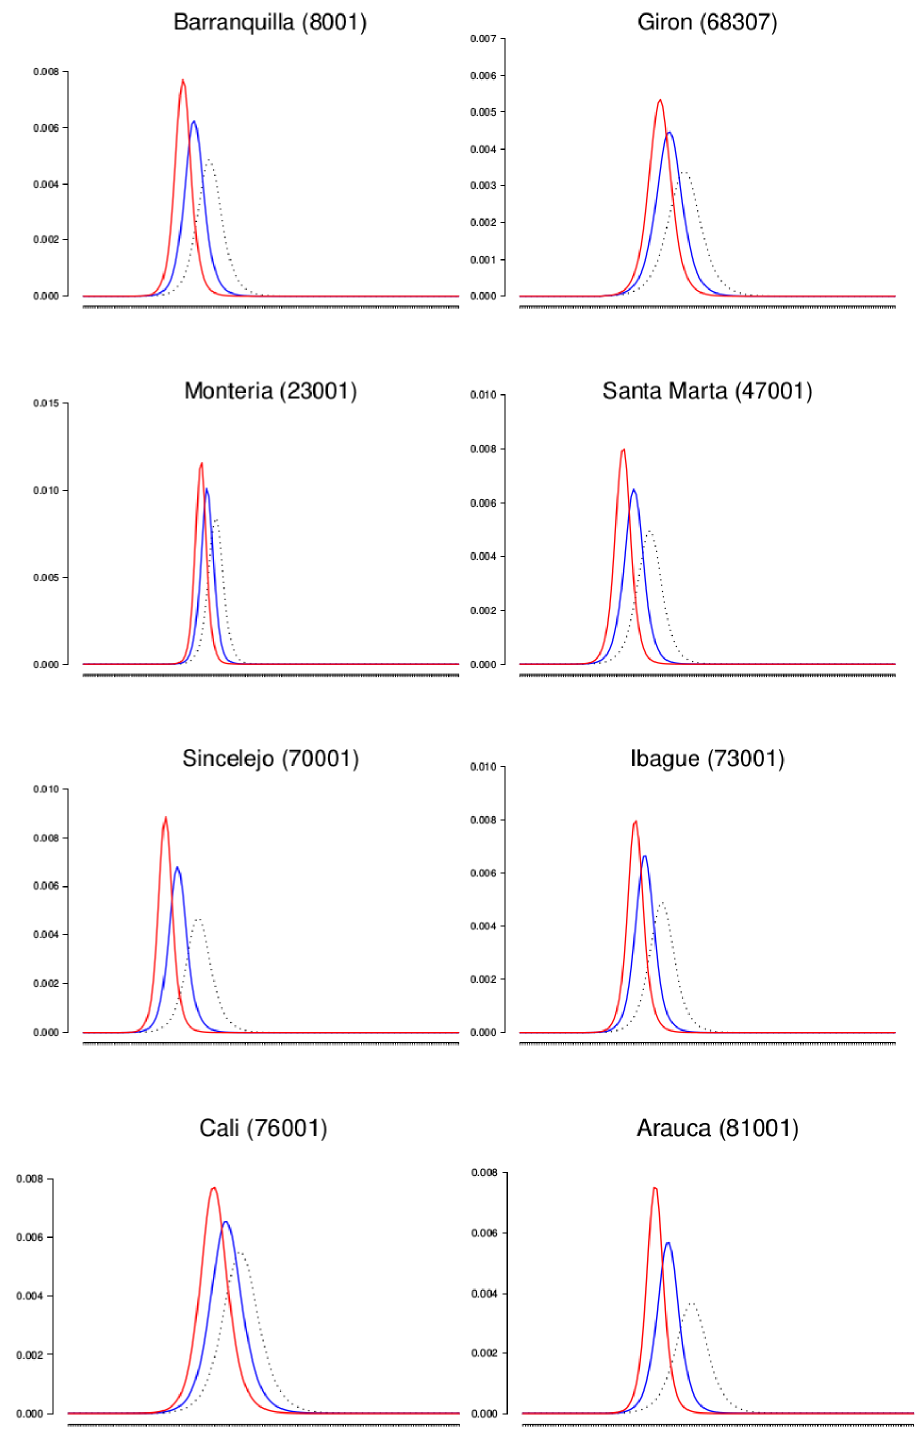
Fig 6. Comparison of the proportion of symptomatic infections of the best fit and the behavior of the epidemics when the number of risky sexual interactions increases. Y-axis is a proportion (infected / at risk population), and the x-axis is time (in weeks). Best fit is dashed line, blue corresponds to ρ = 0.10, and red is ρ = 0.20.